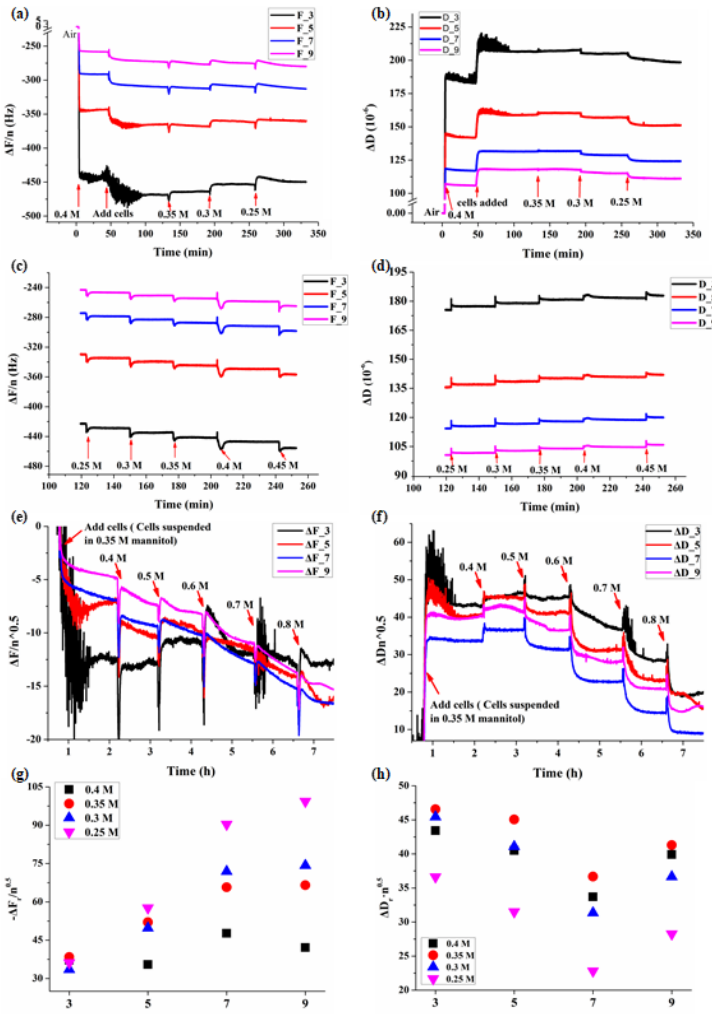
Figure 1. Typical QCM responses during the adhesions of BY-2 cells to (PDADMAC)/SiO 2 crystal followed by osmotic treatments of different mannitol concentrations. ( a , b ) Changes in frequency and dissipation for each overtone during the adhesion of BY-2 cells in 0.4 M mannitol solution followed by hypotonic treatments of mannitol solutions. ( c , d ) The QCM-D responses of the reference (PDADMAC)/SiO 2 crystal without cells in different concentrations of mannitol. ( e , f ) The QCM-D responses during the adhesion of BY-2 cells on (PDADMAC)/SiO 2 crystal in 0.35 M mannitol followed by hypertonic treatments of mannitol solutions. ( g , h ) The relative changes ΔD r = ΔD BY-2 - ΔD Mannitol , ΔF r = ΔF BY-2 - ΔF Mannitol . ΔD r ·n 0.5 and - ΔF r /n 0.5 were not constants for different overtones indicating the viscoelastic feature of living BY-2 cells.